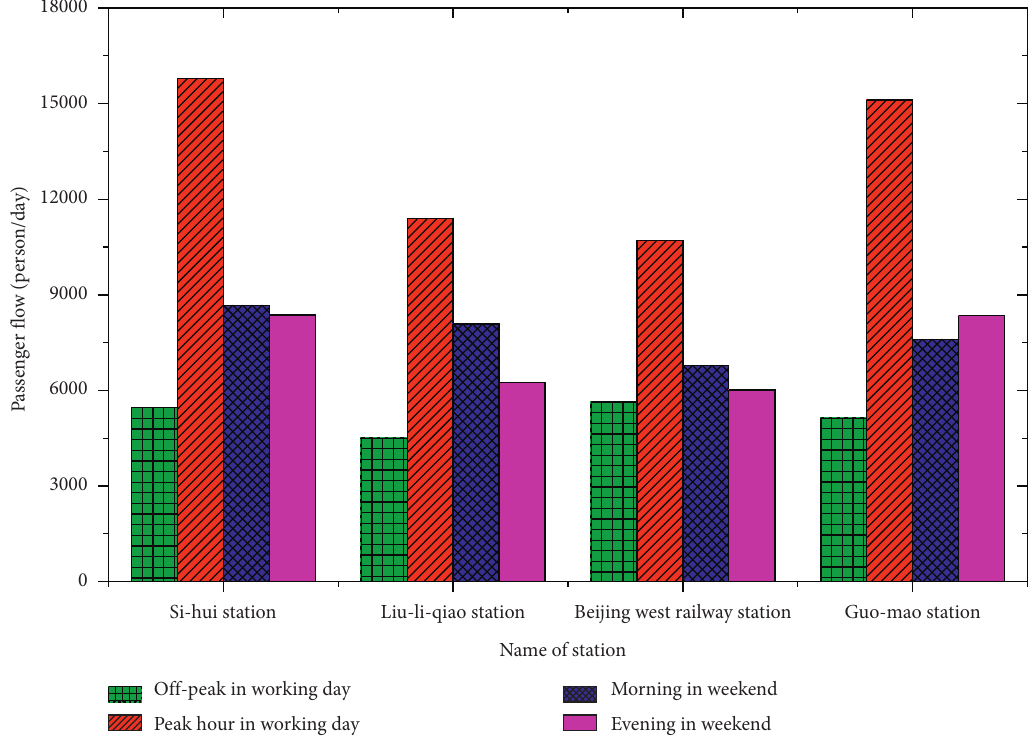
Figure 1: The passenger flow in different